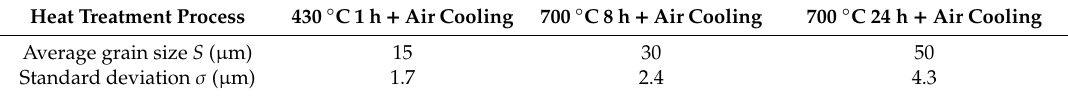
Figure 1. Various grain sizes under di ff erent heat treatment conditions: ( a ) 430 ◦ C for an hour and air cooling; ( b ) 700 ◦ C for 8 h and air cooling; ( c ) 700 ◦ C for 24 h and air cooling. Table 1. Heat treatment process and average grain